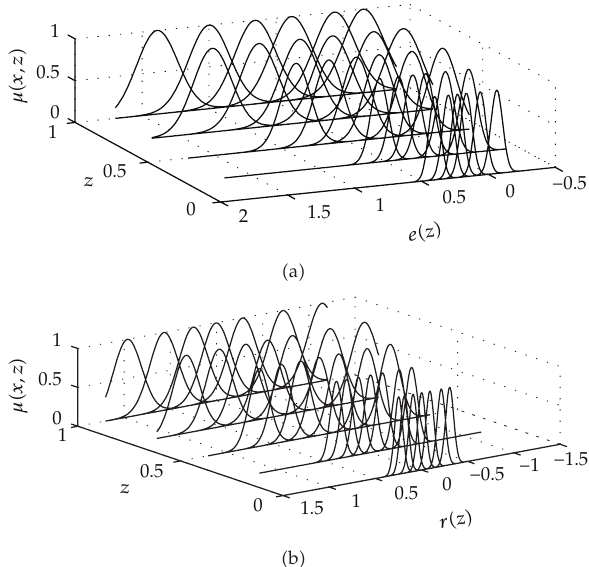
Figure 5: Distributions of Gaussian type 3-D fuzzy sets in the simplified fuzzy-rule